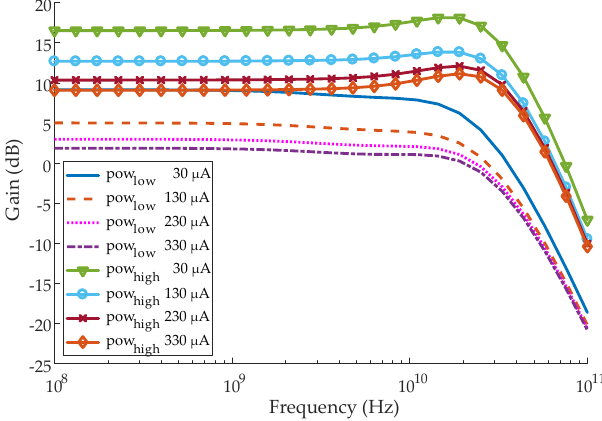
Figure 10. The simulated frequency response of the variable-gain amplifier (VGA).